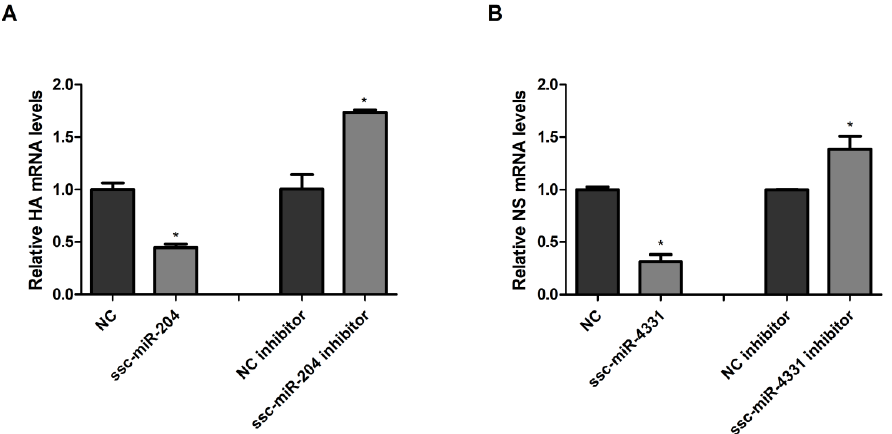
Figure 3. Ssc-miR-204 and ssc-miR-4331 suppressed the expression of SIV-H1N1/2009 HA and NS, respectively. ( A ) NPTr cells were transfected with ssc-miR-204 mimics or inhibitors for 24 h and infected with SIV-H1N1/2009 for 36 h, then the mRNA levels of viral HA were assessed by quantitative real-time PCR (qRT-PCR) method; ( B ) NPTr cells were transfected with ssc-miR-4331 mimics or inhibitors for 24 h and infected with SIV-H1N1/2009 for 36 h, then the mRNA levels of viral NS were assessed by qRT-PCR method. All data were determined using the 2 −ΔΔ C t method and normalized to glyceraldehyde-3-phosphate dehydrogenase (GAPDH). Significant levels were analyzed by Student’s t -test, * p ≤ 0.05.